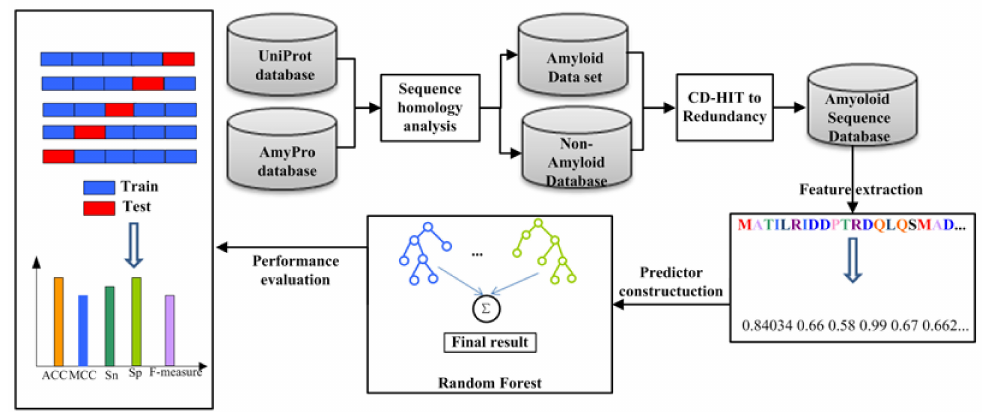
Figure 3. Overview of the paper framework for an Amyloid classifier. First, the original protein sequence was generated from the Uniprot and AmyPro datasets and then subjected to a de-redundant operation to generate the final protein sequence data called Amy. The second step is feature extraction of protein sequences. The third step is to use RF to classify protein